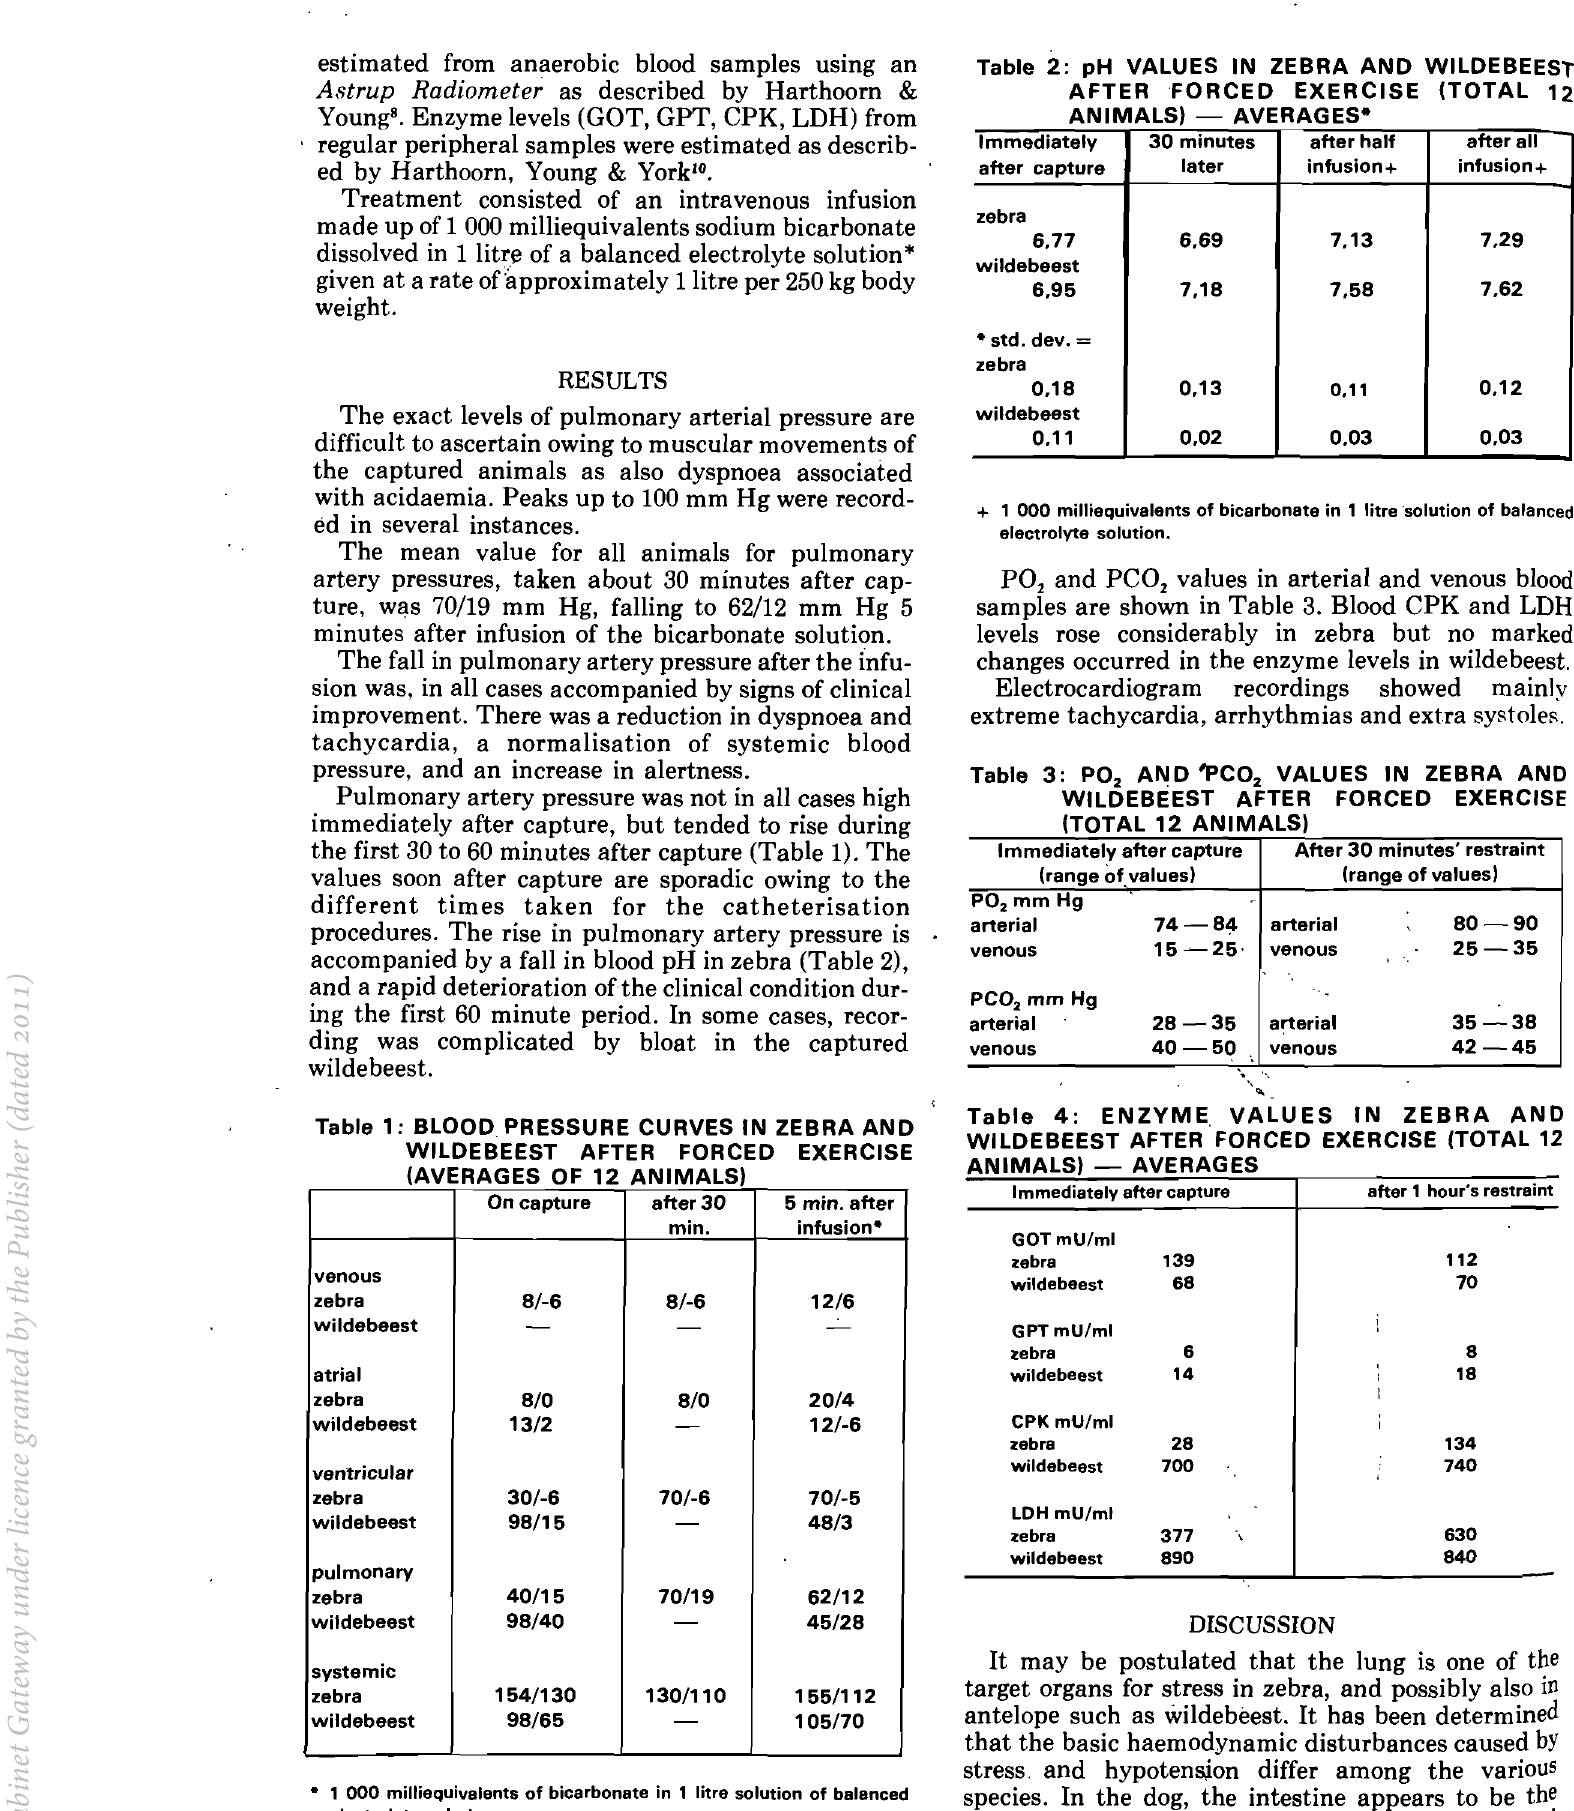
Table 2: pH VALUES IN ZEBRA AND WILDEBEEST AFTER FORCED EXERCISE (TOTAL 12 ANIMALS) - AVERAGES·